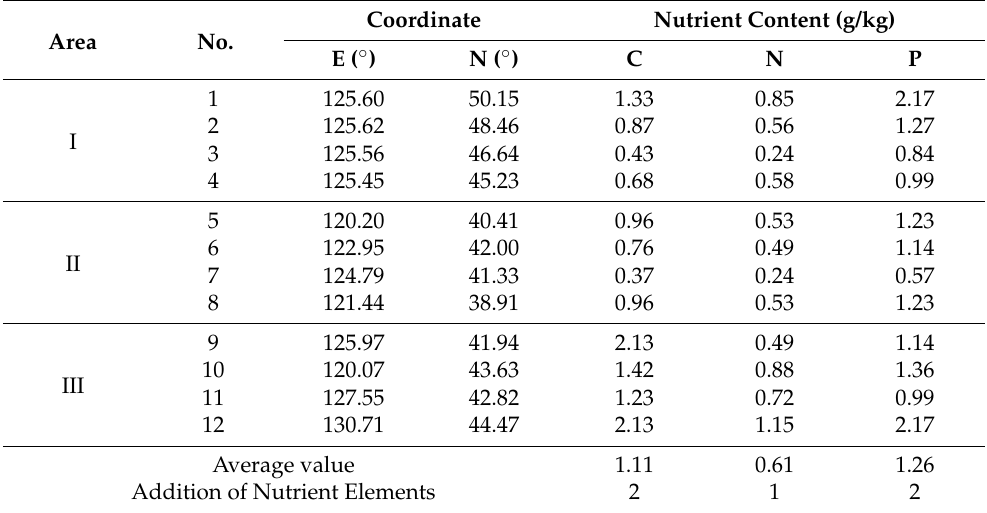
Table 6. Investigation on background values of nutrient elements in agricultural soil based on the sampling